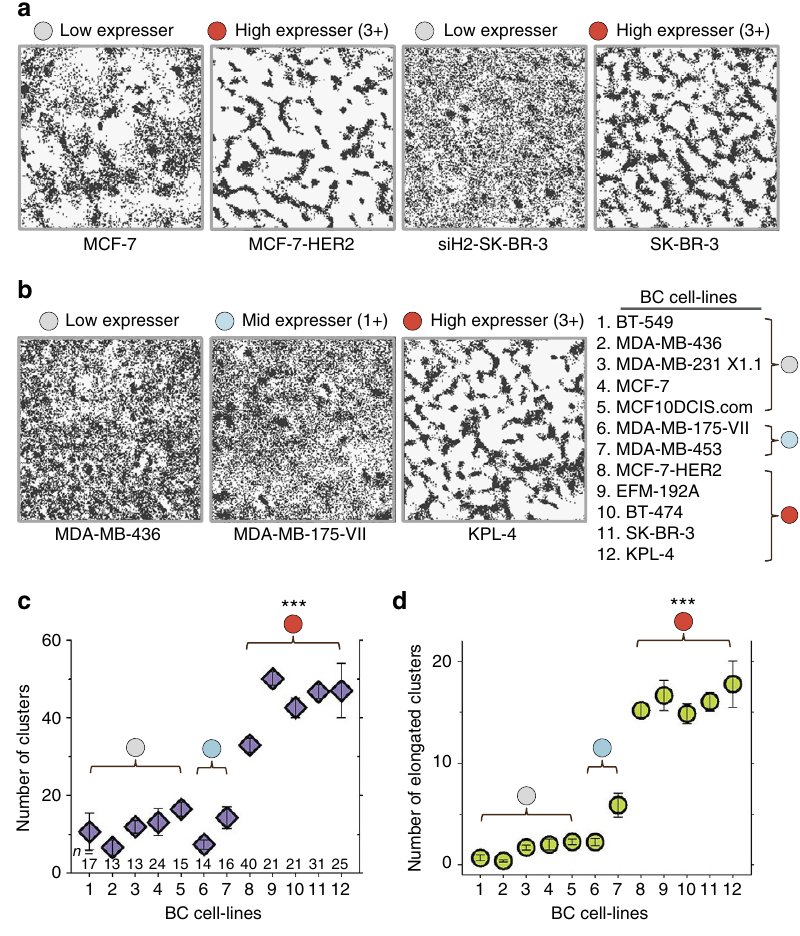
Figure 1 | Contrasting HER2 distributions in high versus low expressers. ( a ) A HER2 distribution was constructed from the sum of individual receptor location points (black dots) acquired from tracking single HER2s in the basal cell membrane, for 100s with an acquisition rate of B 11Hz. Each distribution contains B 60,000 location points in the 8 m m (cid:2) 8 m m field. It was assumed that the membrane as a whole was stationary during this time window. In high HER2 expressers, MCF-7-HER2 and SK-BR-3 (3 þ , red circle), HER2 locations appeared ‘clustered’ in elongated shapes while they are randomly distributed in the low expressers, MCF-7 and siH2-SK-BR-3 (light grey circle). ( b ) Elongated HER2 clusters are also observed in high expressers (red circle, KPL-4), much less in the mid (light blue circle, MDA-MB-175-VII) and almost invisible in low expressers (light grey circle, MDA-MB-436). All fields are 8 m m by 8 m m. The list of BC cell-lines with different HER2 levels that are used in c and d ). ( c ) The numbers of clusters (mean ± s.e.m.) identified in these fields. ( d ) The numbers of elongated clusters (mean ± s.e.m.) with the IQ values o 0.25. *** P value o 10 (cid:3) 6 by two-sided, unpaired Welch’s t